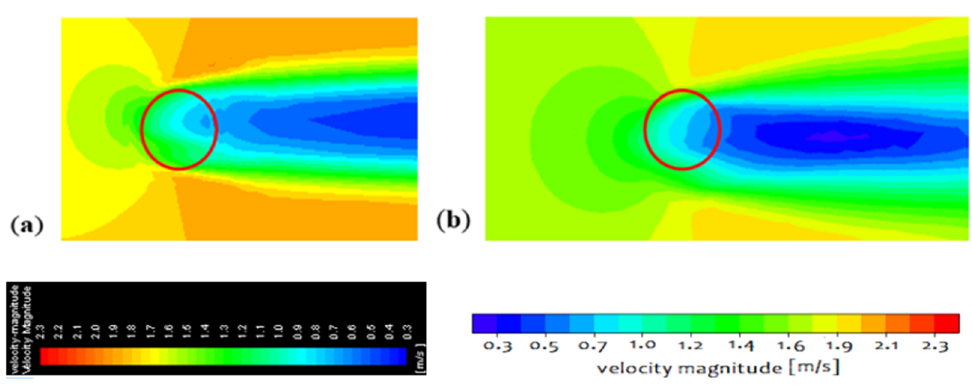
Figure 14. Qualitative flow field detail for ( a ) the ANSYS hybrid model and ( b ) the SHYFEM hybrid model.